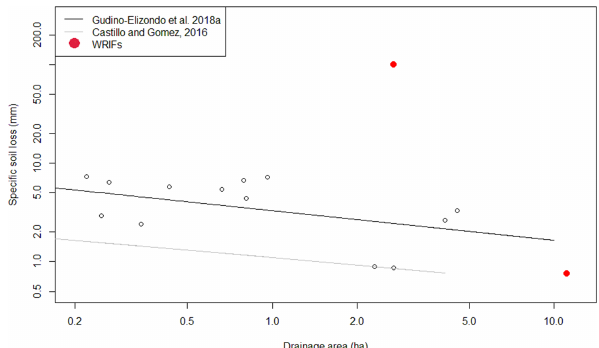
Figure 8. Specific soil loss of mega-gullies caused by WRIF (red dots) compared to previously reported gullies in Tijuana, Mexico (circle points and black line; Gudino-Elizondo et al., 2018a), and trends for ephemeral gullies reported from other sites (gray line; Castillo and Gómez,